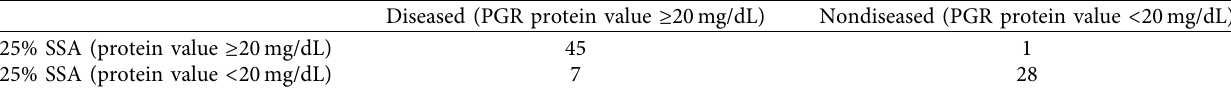
Table 3: Patient data for the calculation of performance characteristics of the 25% sulfosalicylic acid protein concentration versus pyrogallol red protein concentration.